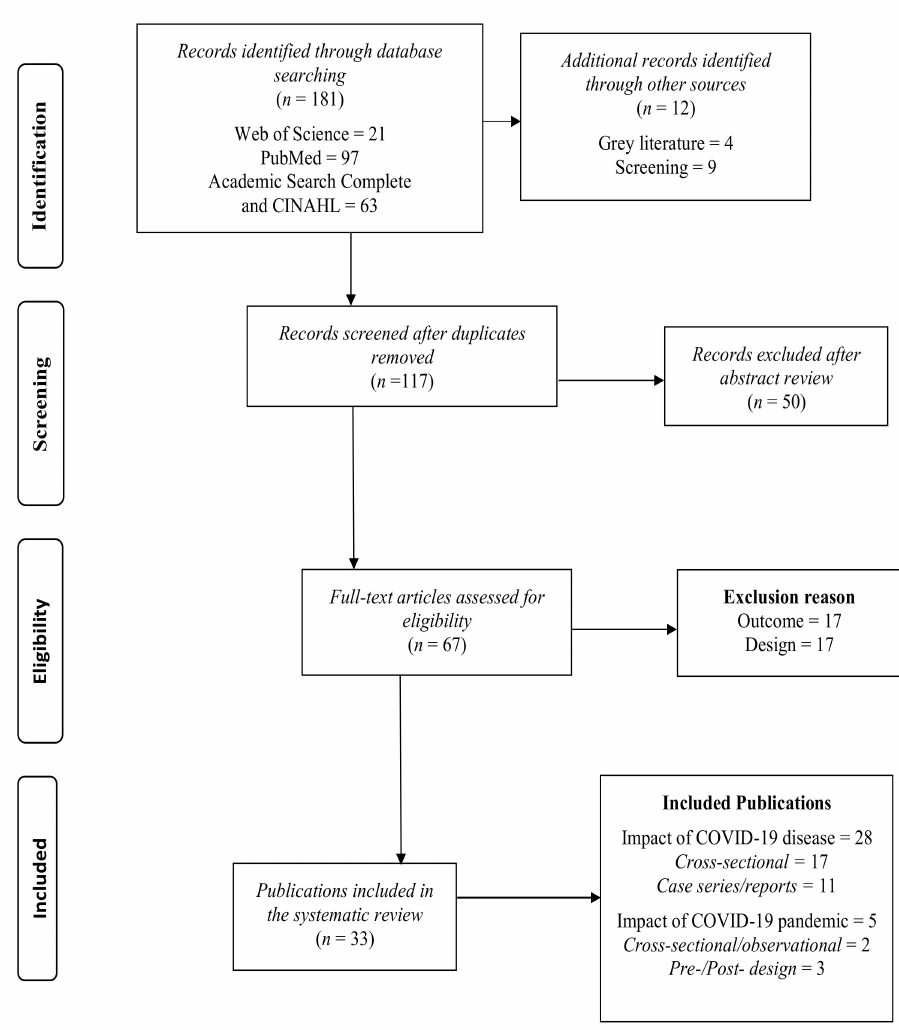
Figure 1. Prisma